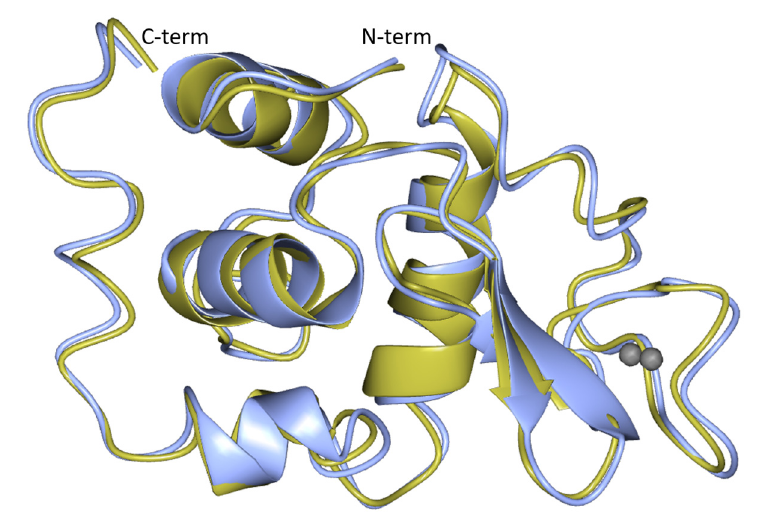
Figure 12. Ribbon representation of HEWL protein. The model obtained by molecular replacement using the in-house collected data (blue) is superposed on the known structure of HEWL (yellow) (pdb code: 3a8z). The grey spheres correspond to Na + atoms. The superposition of the pdb model and the calculated structure generate an rmsd (root-mean-square deviation of atomic position) of 0.83 Å for 129 α carbon atoms. The picture was produced by using the program CCP4mg.